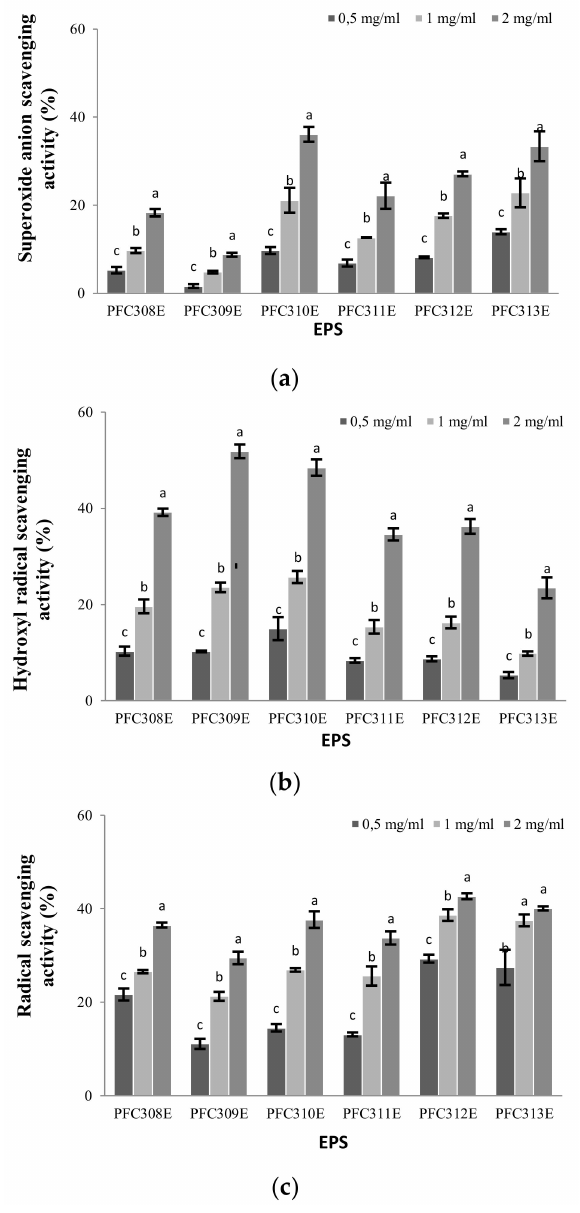
Figure 3. The antioxidant activity of ropy EPS at di ff erent concentrations. Scavenging activities ( a ) Superoxide anion, ( b ) hydroxyl radical and ( c ) radical. Di ff erent letters show the di ff erences ( p < 0.05) between the concentrations at each